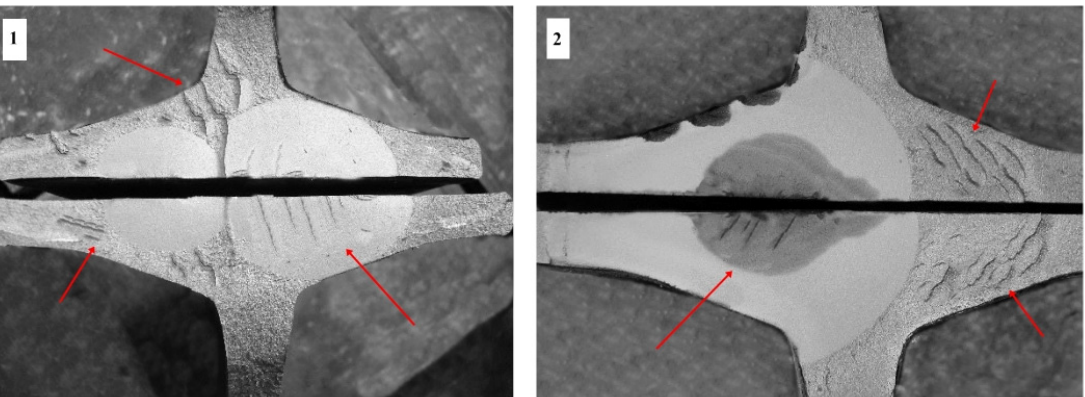
Figure 12. Examples of fatigue fracture of the flash shaft: 1 —welded connection of rails for R260 steel, 2 —butt welded connection for R350HT steel.